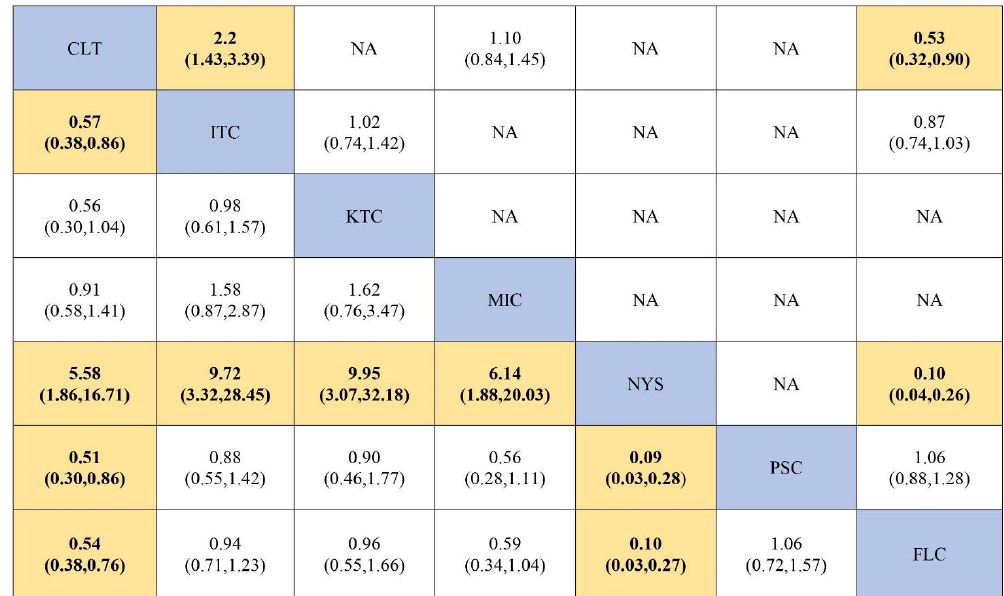
Figure 7. SUCRA ranking curve for the efficacy of antifungal agents used for the treatment of OPC among HIV-infected adults (mycological cure). Abbreviations: CLT—clotrimazole, FLC—fluconazole, ITC—itraconazole, KTC—ketoconazole, MIC—miconazole, NYS—nystatin, PSC—posaconazole. X -axis: ranking of treatment. Y -axis: probability of a given treatment to be the first, second, third, or fourth best. In this example, treatment A has the largest probability to be the first best treatment.